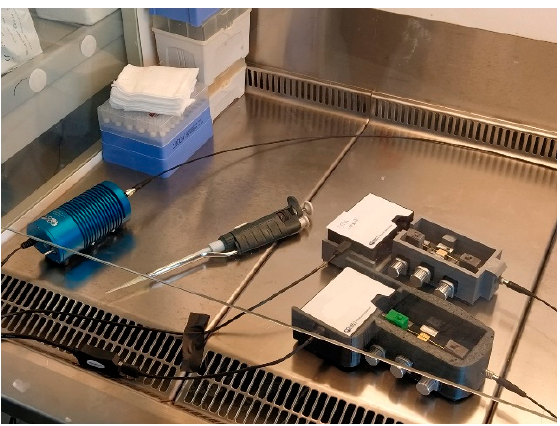
Figure 7. Picture of two SPR-POF-MIP sensor systems, used in parallel for the SARS-CoV-2 detection in real samples (UTM and physiological solution).